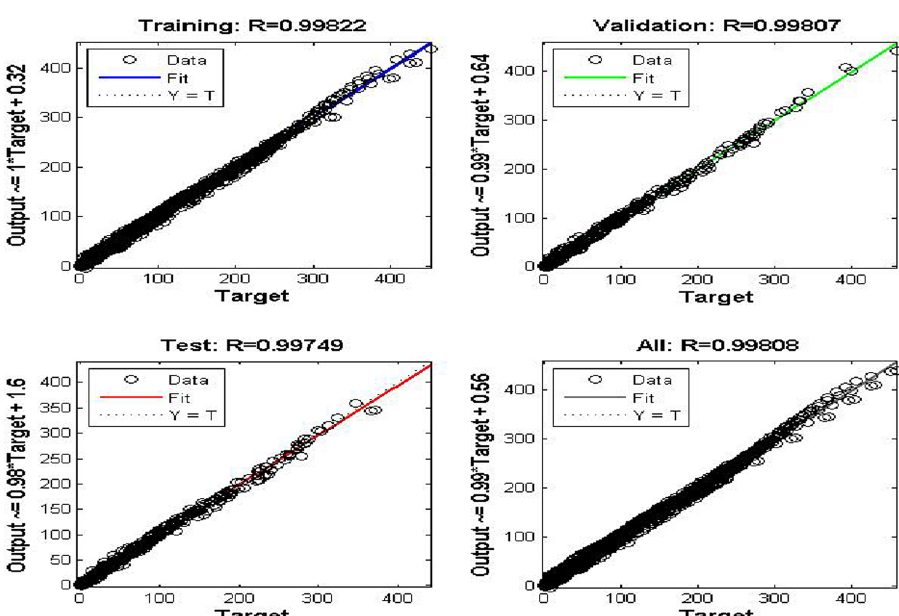
Fig. 5 Results of type-2 neural network using two hidden